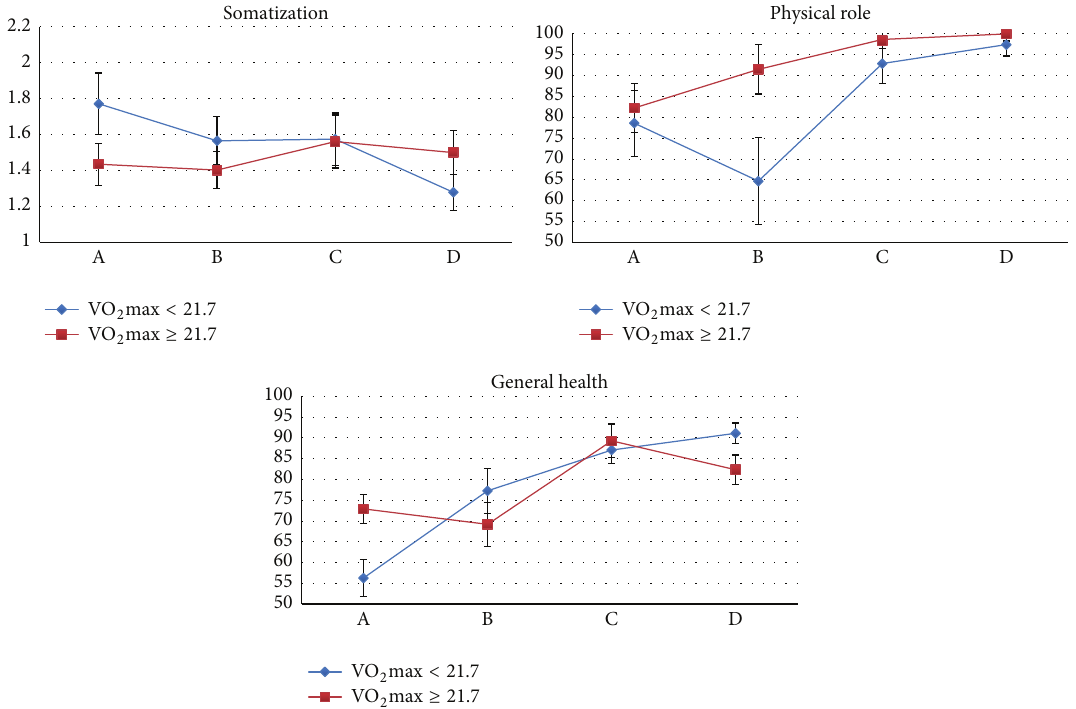
Figure 2: Estimated means and standard errors (bars) across follow-ups for patients with a baseline physical fitness level lower and higher than the sample median (VO 2 max = 21.7mL/min/kg). Only significant interaction effects of physical fitness level and follow-up are illustrated. The somatization subscale of the “Symptoms Checklist” (SCL-90) is scored from 1 to 4 with higher scores indicating more mental distress. The physical role and general health subscales of the “Short Form Health Survey 36” (SF-36) are scored from 1 to 100 with higher scores reflecting better health-related quality of